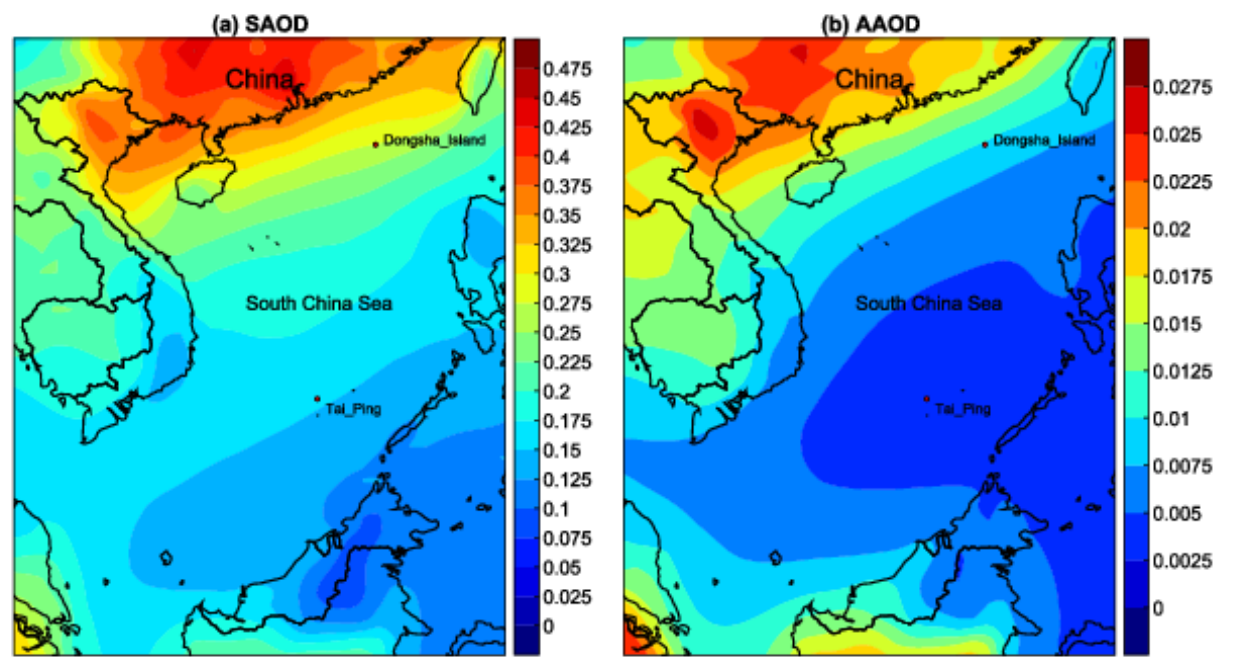
Figure 5. Spatial distribution of mean values of ( a ) scattering aerosol optical depth (SAOD) and ( b ) absorption aerosol optical depth (AAOD) over the SCS in the period of 1980–2020. Aerosol